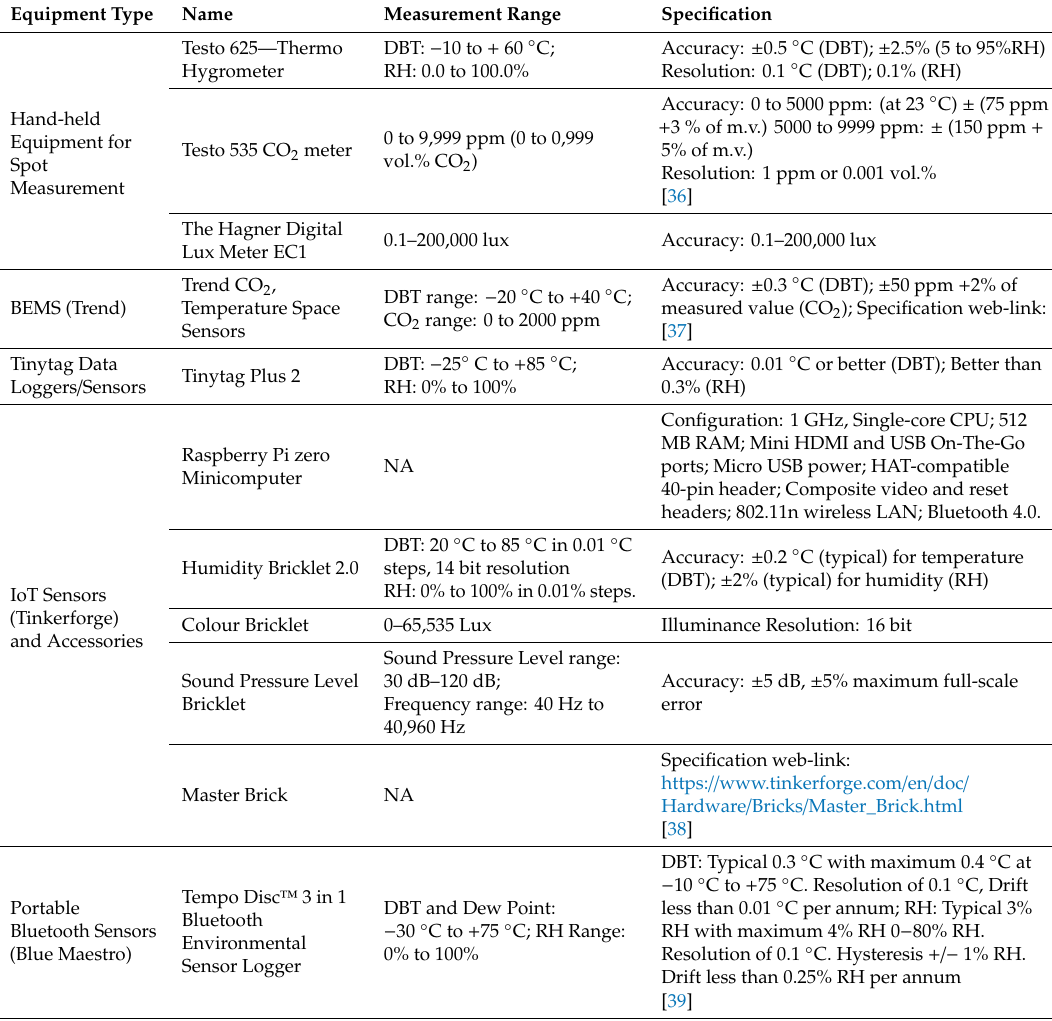
Table A1. Specifications of BEMS, IoT Sensors and other equipment (source: manufacturers’ technical